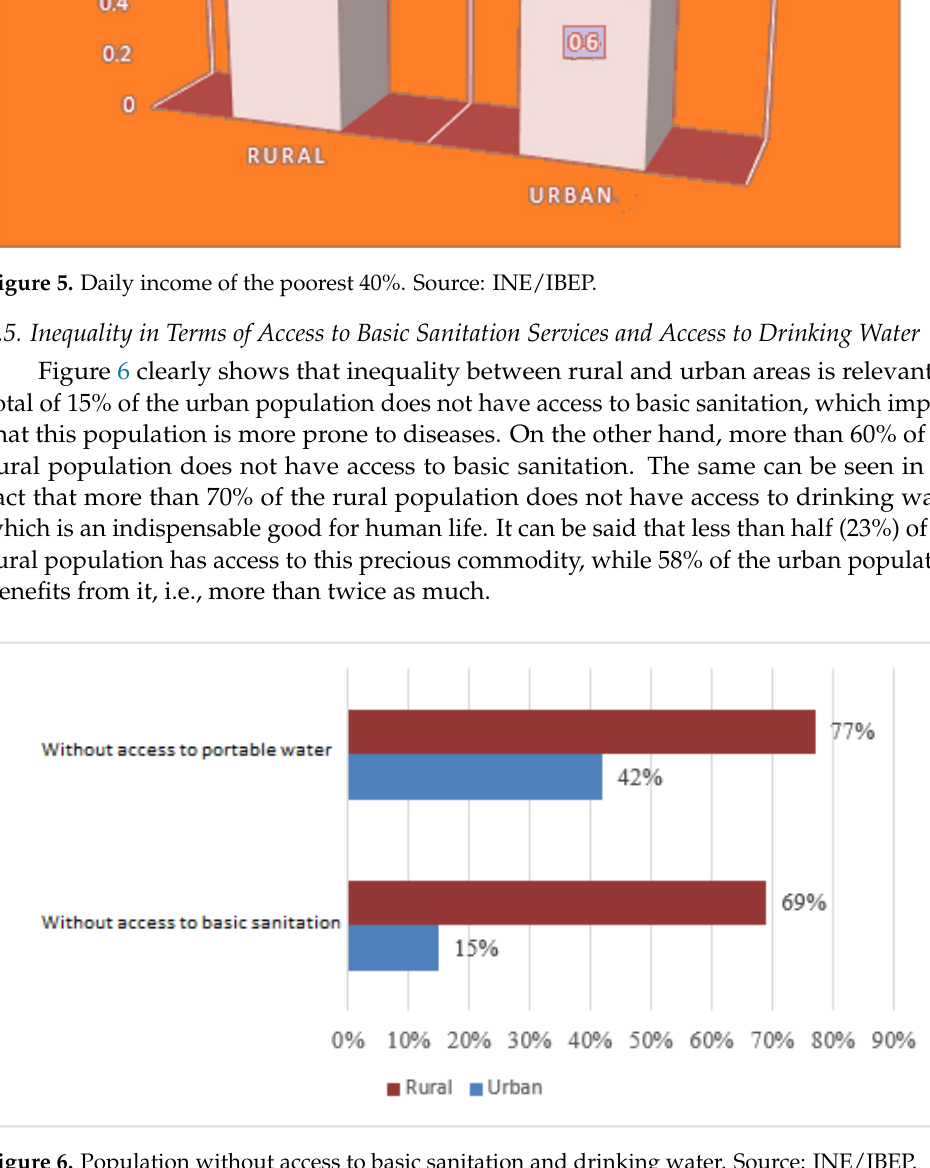
Figure 4. Industrial development axes in Angola. Source: Instituto Cartográfico de Angola (2020).